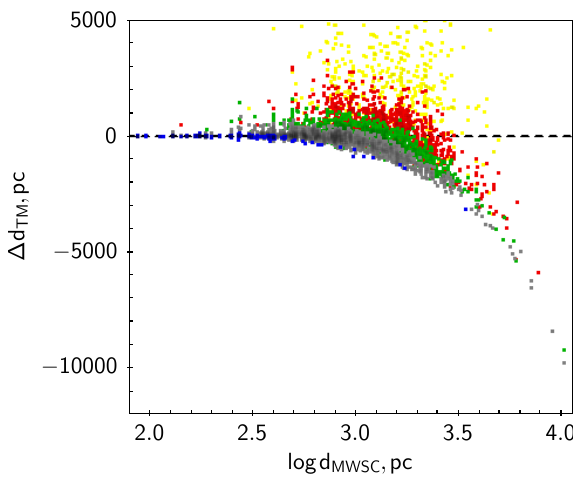
Figure 3. Relation between ∆d = d TGAS − d MWSC and log d MWSC of probable cluster members. Colours of the dots are as at Figure 2.